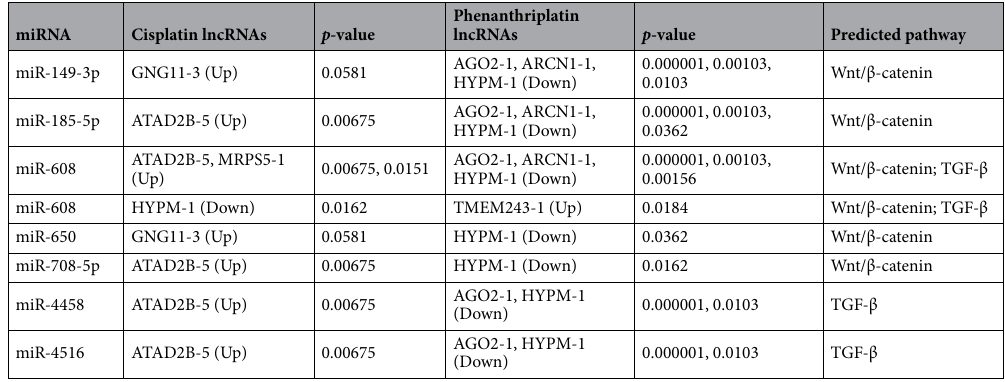
Table 4. MiRNAs projected to target regulated lncRNAs in IMR90 cisplatin and phenanthriplatin treated cells and predicted pathway signaling ( p ≤ 0.05, except GNG11-3, p ≤ 0.0581).